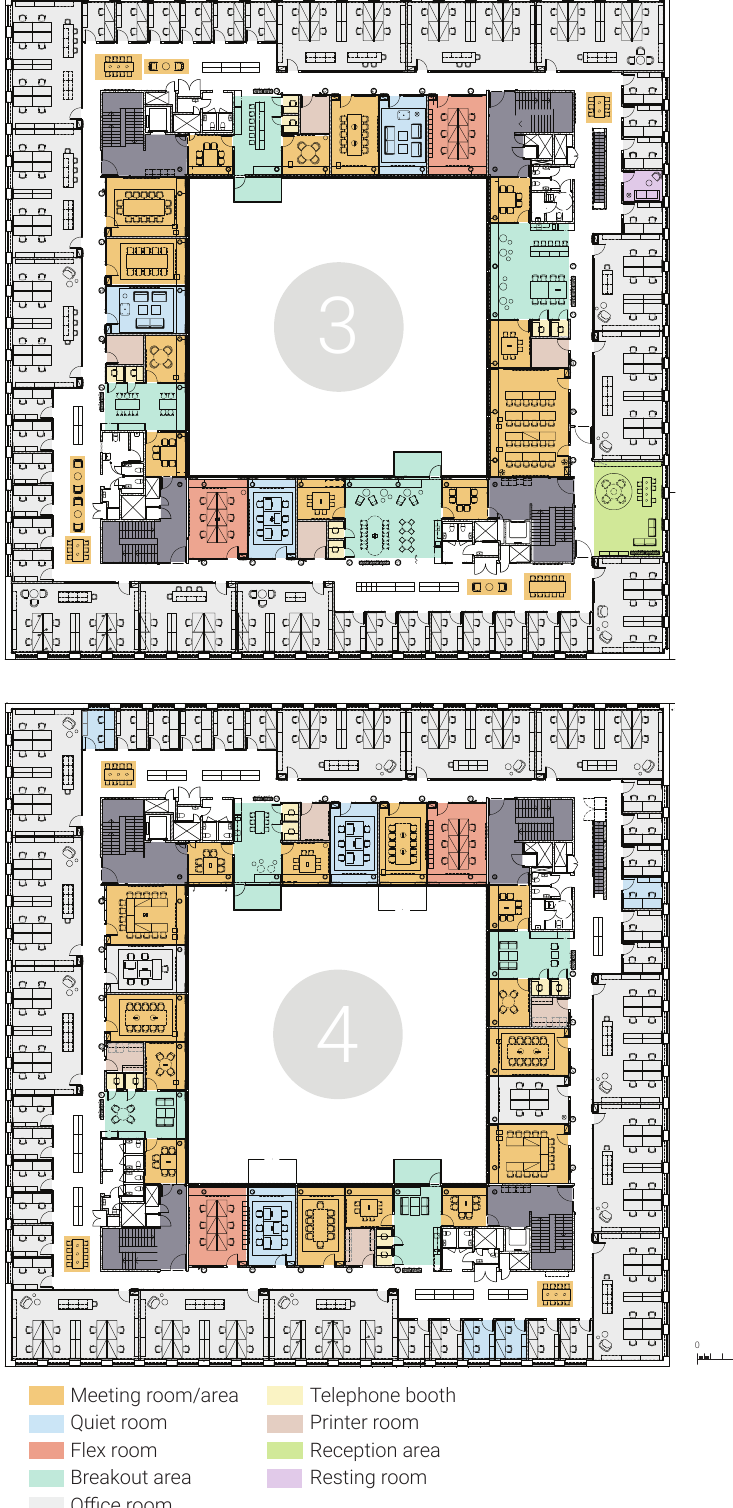
Figure 3. Floor plans of the studied